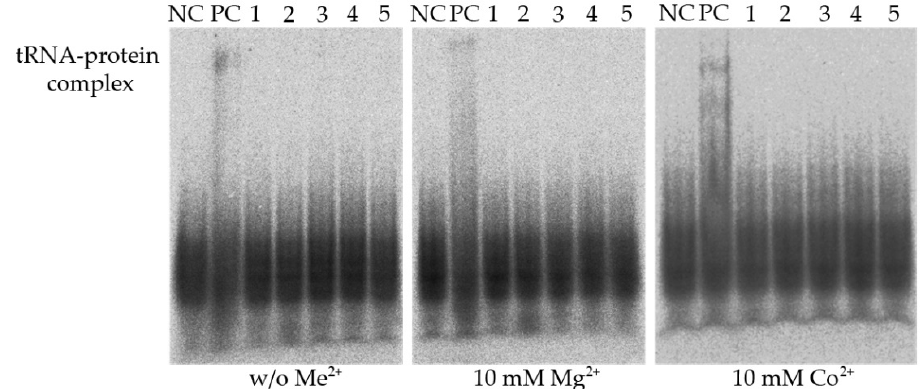
Figure 1. Evaluation of binding of YqfB and ASCH domain-containing YqfB-like proteins to tRNA in the presence and absence of metal ions in EMSA. NC—tRNA control without added protein samples, PC—positive control, tRNA pseudouridine synthase B (TruB). 1-5—tRNA incubated with YqfB, BagYqfB, CunYqfB, KpnYqfB and SloYqfB, respectively.